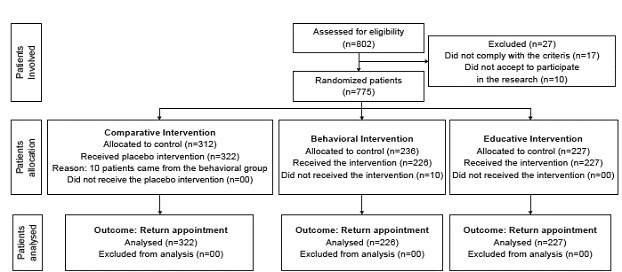
Flowchart of research development